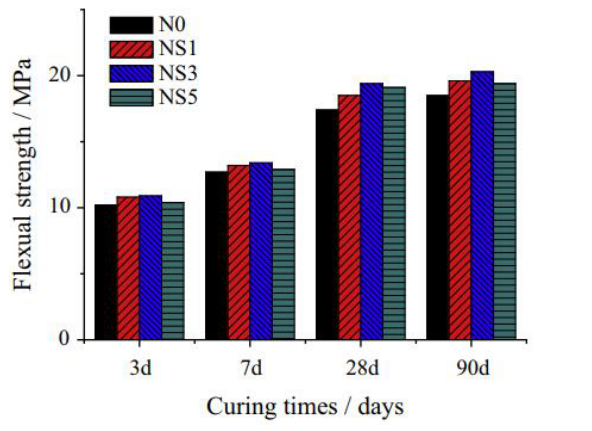
Figure 3: Flexural strength of UHPCCs at different curing ages [76]